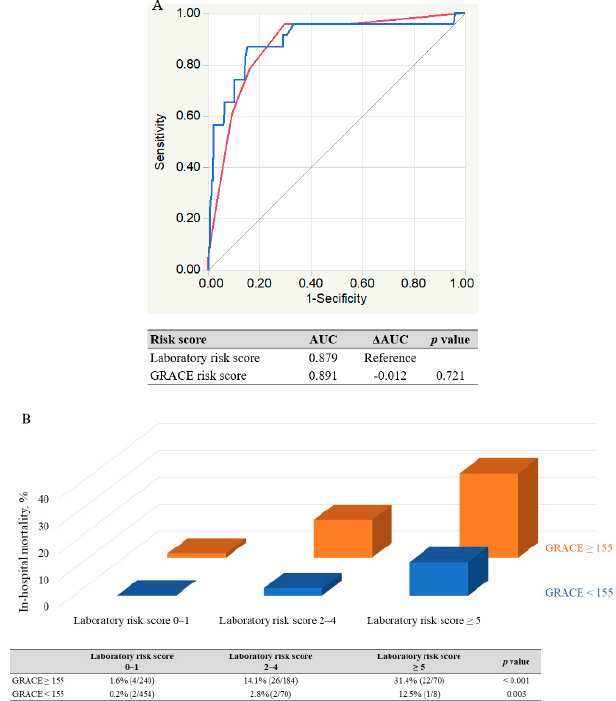
Figure 5. Comparison between laboratory risk score and Global Registry of Acute Coronary Events (GRACE) risk score. ( A ) Area under the curves (AUCs) of laboratory risk score (red) and GRACE risk score (blue) in validation cohort were 0.879 (95% confidence interval (CI) 0.790–0.931) and 0.891 (95% CI 0.773–0.952), respectively, and the difference was not significant. ( B ) Substratification by the combined laboratory parameter risk scores of all patients stratified according to GRACE risk scores.